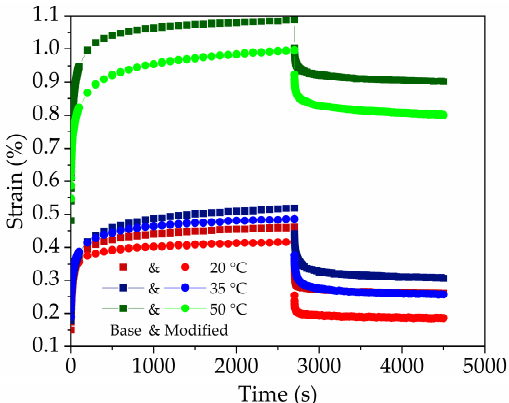
Figure 7. Creep deformations versus time for base bituminous mixture and nano-TiO 2 /CaCO 3 modified bituminous mixture at 20 °C, 35 °C and 50 °C.